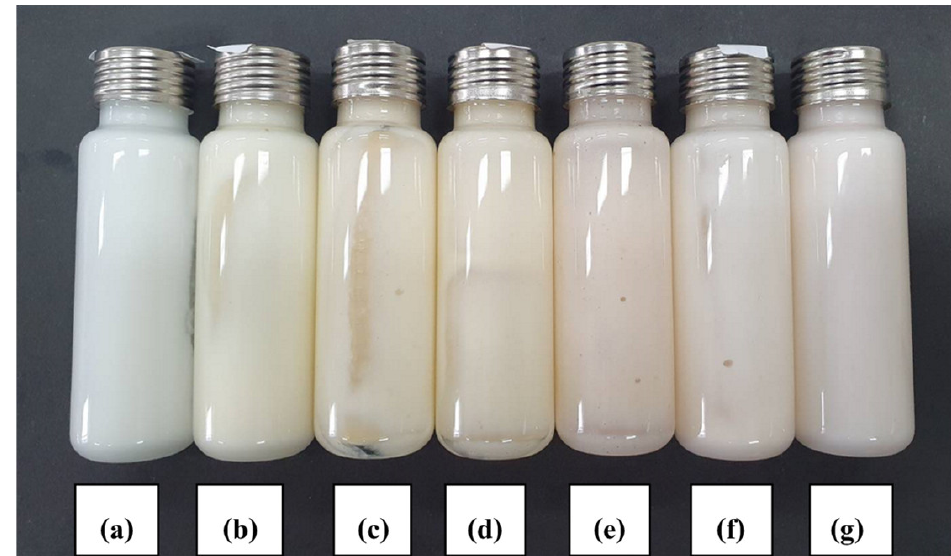
Figure 5. Deodorant cream with 2.0% H-CMCH by heating/cooling cycle; ( a ) cycle 0, ( b ) cycle 1, ( c ) cycle 2, ( d ) cycle 3, ( e ) cycle 4, ( f ) cycle 5, and ( g ): cycle 6.